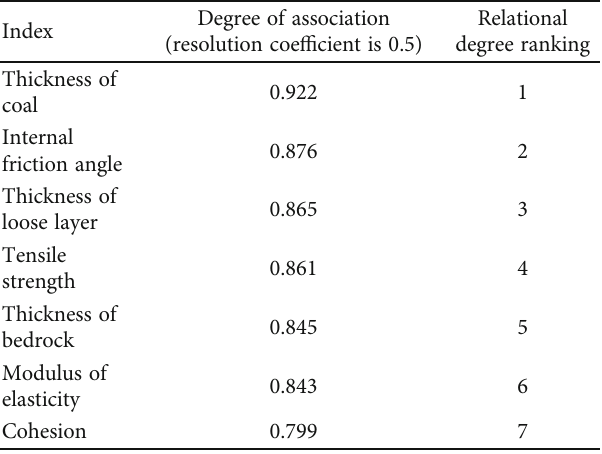
Figure 19: Fitting curve of maximum subsidence/subsidence coe ffi cient and internal friction angle. Table 2: Results of grey relational degree